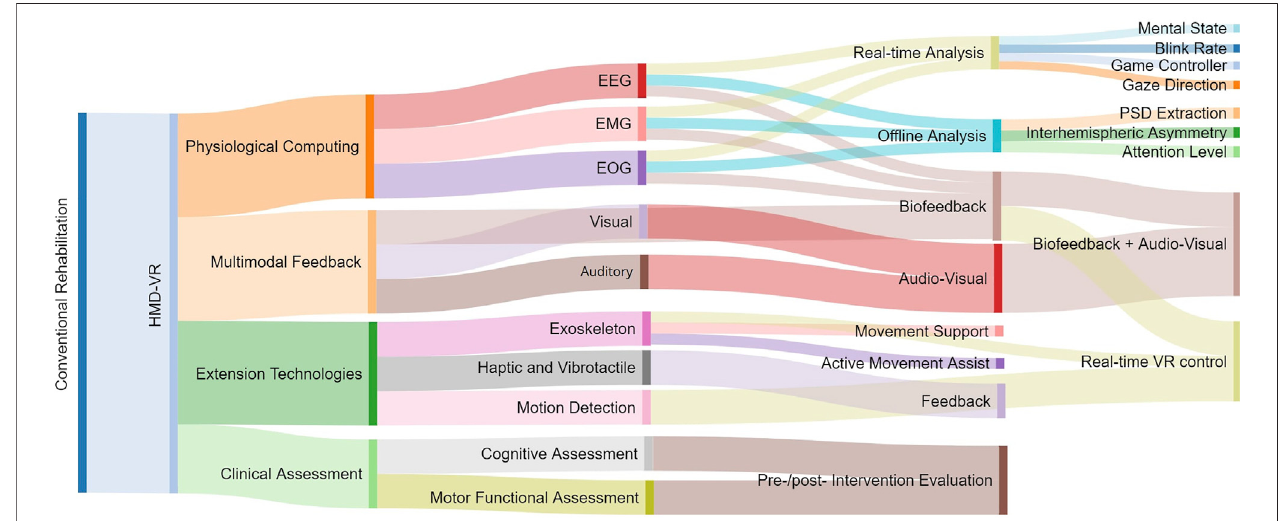
FIGURE2| Alluvialdiagramillustratingmediatedapproachesand theircombinationstoshape signi fi cantusagewithintheframework ofHMD-VRforrehabilitation.